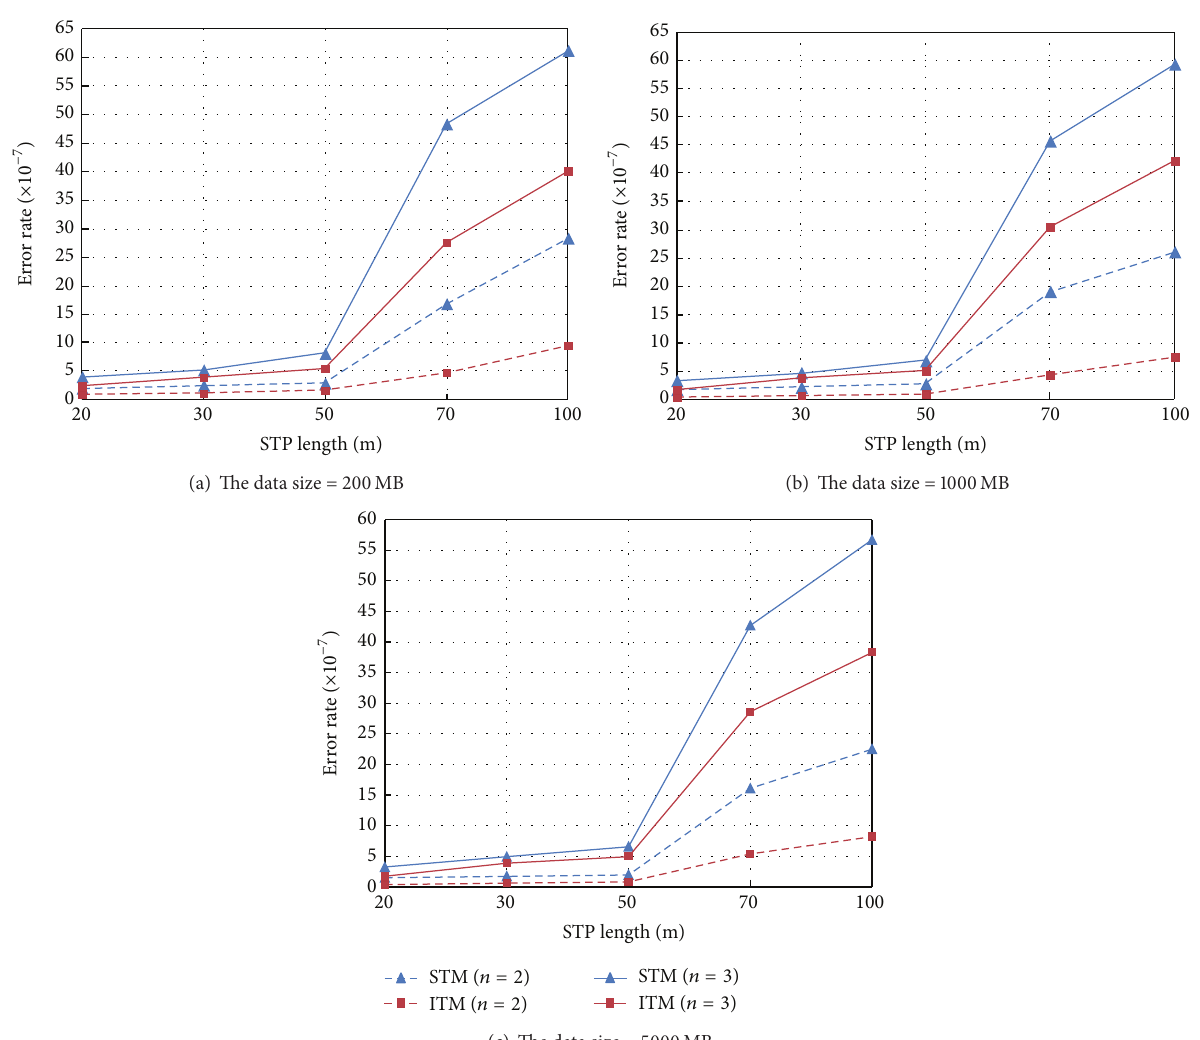
Figure 9: The error rate as a function of the STP length when data size is 200 MB, 1000 MB, or 5000